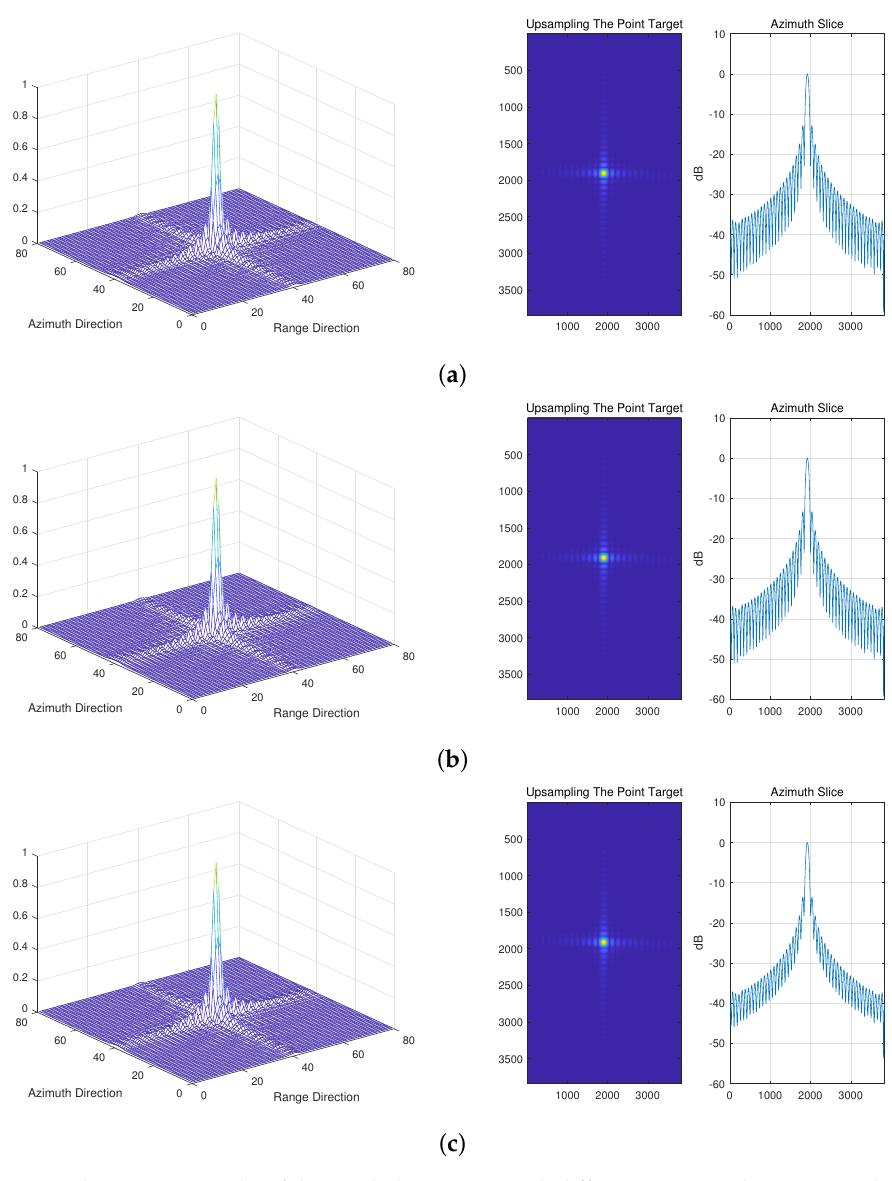
Figure 10. The imaging results of the parabolic antenna with different pointing deviations in the case of misalignment. ( a ) Pointing deviation = 5 ◦ ; ( b ) pointing deviation = 7 ◦ ; ( c ) pointing deviation = 9 ◦